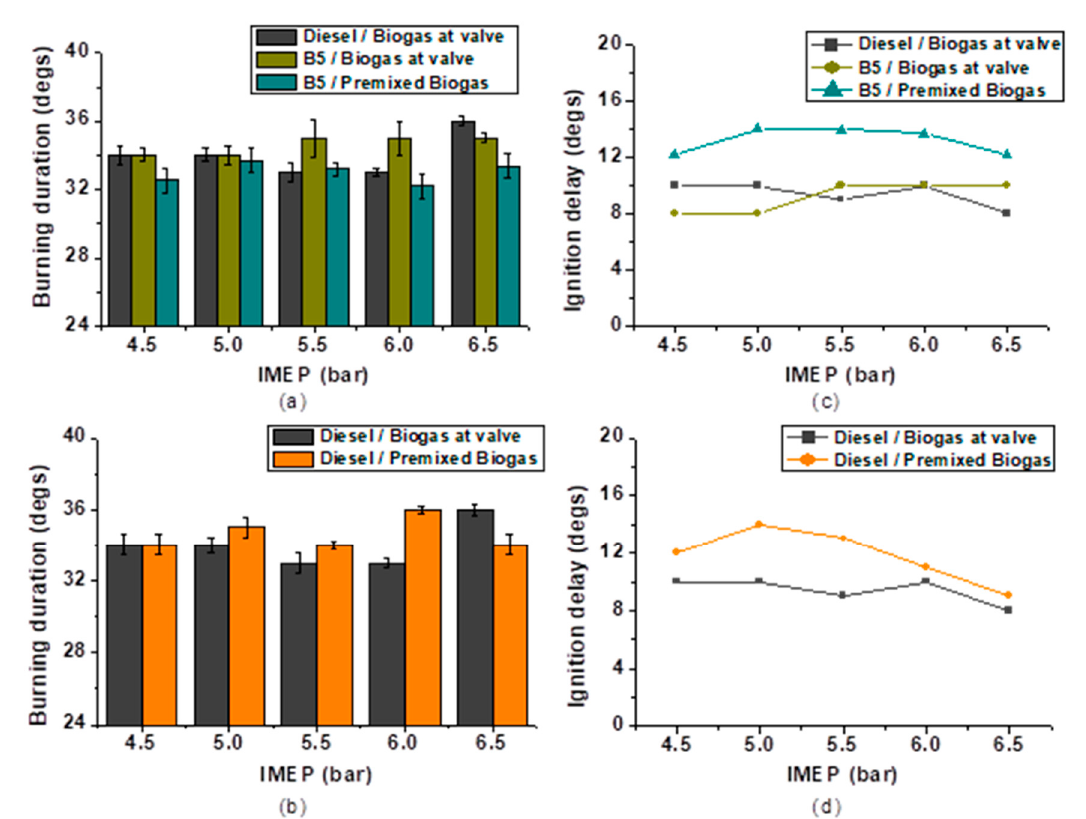
Figure 12. Variation of ( a ) burning duration for B5/biogas RCCI combustion, ( b ) burning duration for biogas injection approaches in RCCI, ( c ) ignition delay period for B5/biogas RCCI combustion, and ( d ) ignition delay for biogas injection approaches in RCCI.